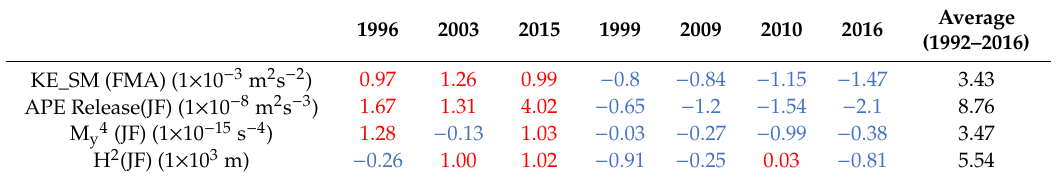
Table 1. KE_SM anomaly averaged from February to April and the parameterized APE release, M y4 , and H 2 anomalies averaged from January to February in 1996, 2003, and 2015 with enhanced submesoscale motions and in 1999, 2009, 2010, and 2016 with decayed submesoscale motions in the STCC region. The values with red and blue color are larger and smaller than the means, respectively.